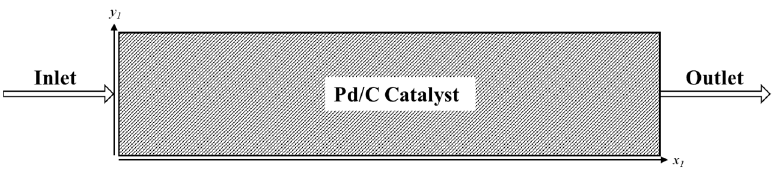
Figure 14. Schematic representation of the packed bed microreactor used for the CFD studies.